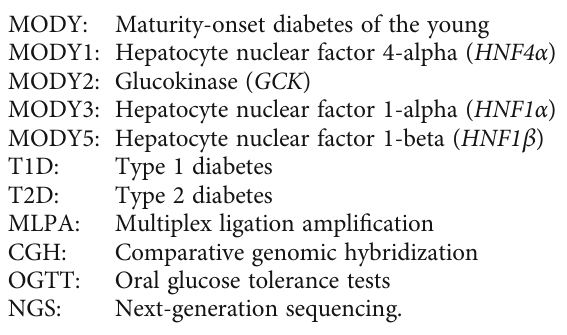
Supplemental Table 1: primers used for HNF4 α , GCK , HNF1 α , and HNF1 β genes for sequencing analysis. Supple- mental Table 2: clinical characteristics of MODY cases with or without variants in each gene. Supplemental Figure 1: sequences of two novel GCK gene mutations and one novel HNF4 α gene mutation. Supplemental Figure 2: results of array CGH (human genome CGH array 244K). Supplemen- tal Figure 3: pedigrees of the families of the probands with mutations in GCK , HNF1 α , HNF4 α , and HNF1 β genes, respectively. (Supplementary